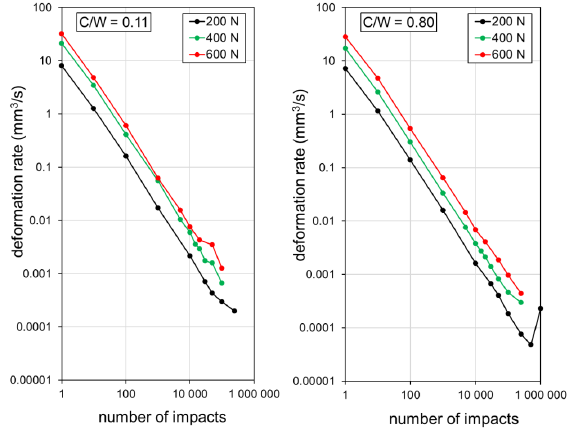
Figure 5. Deformation rate of the W-B-C coatings.